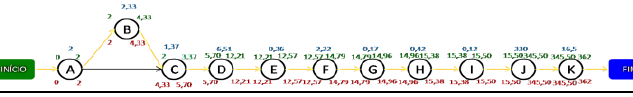
Figura 6: Caminho crítico do processo. Fonte: Autores,